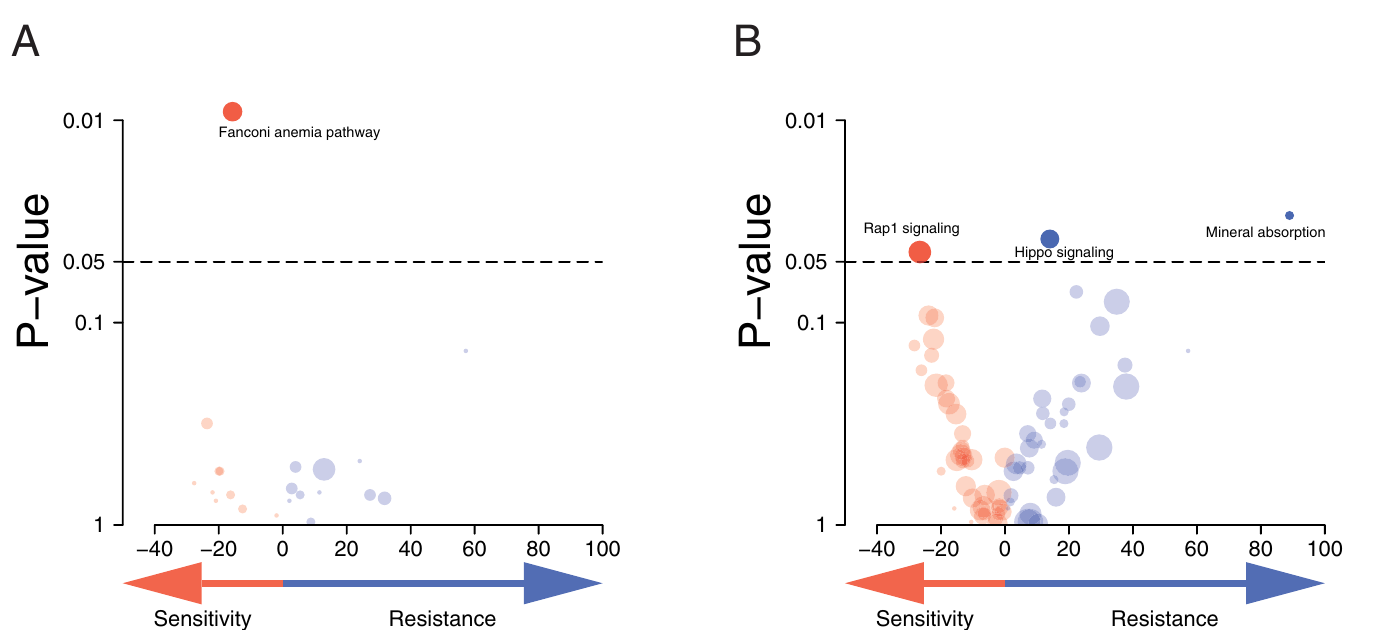
Fig 2. Homozygous and rare SNP variant selection criteria identify the KEGG Fanconi anemia pathway to be strongly associated with MMC response. Volcano plot showing the significance of the associations between MMC response and ‘pathway-mutation’ classification in the individual KEGG pathways as determined by the presence of homozygous and rare SNP variants in these pathway genes. The x-axis shows the difference in mean MMC IC 50 between ‘pathway mutated’ and ‘pathway non-mutated’ cell lines. Pathway mutated cell lines are those with one or more variants in any gene of the individual KEGG pathway. The y-axis shows the significance values (Wilcoxon rank-sum test p -value) of the difference that were found in the MMC IC 50 between ‘pathway-mutated’ and ‘non-mutated’ cell lines. Dot size is proportional to the number of ‘pathway-mutated’ cell lines, dot color intensity proportional to significance value. (A) Results after applying the variant selection strategy that selects homozygous variants (VAF � 0.8) and includes rare SNPs (MAF � 1%). (B) Results of analyses that select variants regardless of zygosity status, including rare SNPs (MAF � 1%).